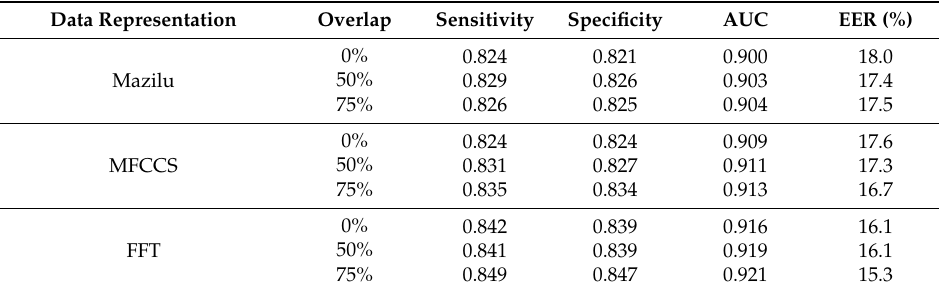
Table 4. Leave-one-subject-out (LOSO) evaluation with a Random forest classifier with 100 estimators for di ff erent data representation and window